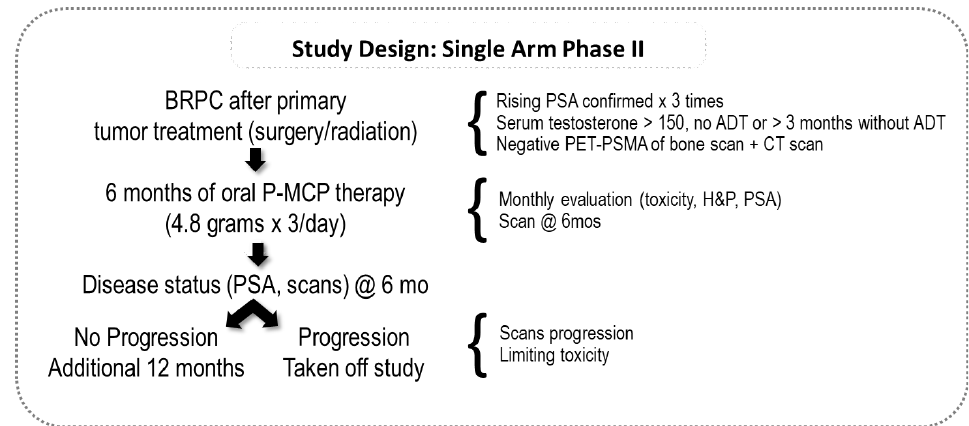
Figure 1. Study design. BRPC (Biochemically Relapsed Prostate Cancer); P-MCP (PectaSol ® Modi- fied Citrus Pectin); @ 6mo (at six months); ADT (Androgen Deprivation Treatment); PET-PSMA (Positron Emission Tomography-Prostate-Specific Membrane Antigen Scan; CT (Computed Tomog- raphy Scan); H&P (History and